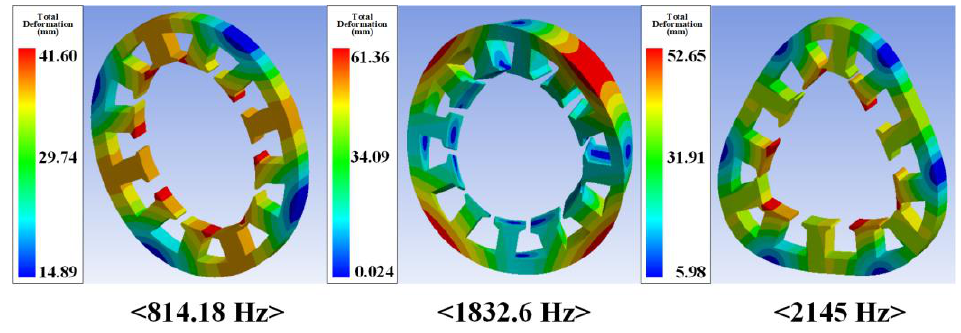
Figure 9. Modal analysis result.